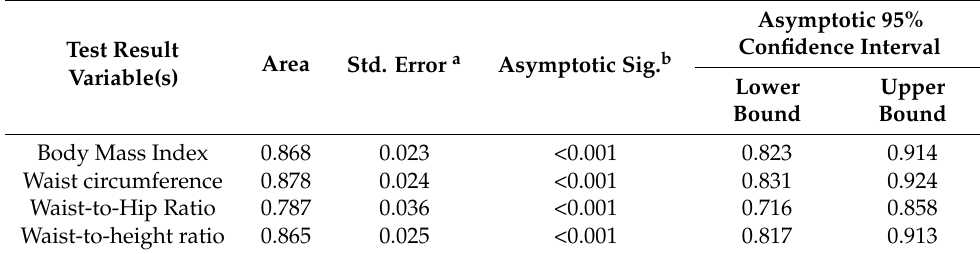
Table 6. Area under receiver operating characteristic curves of metabolic indices for screening